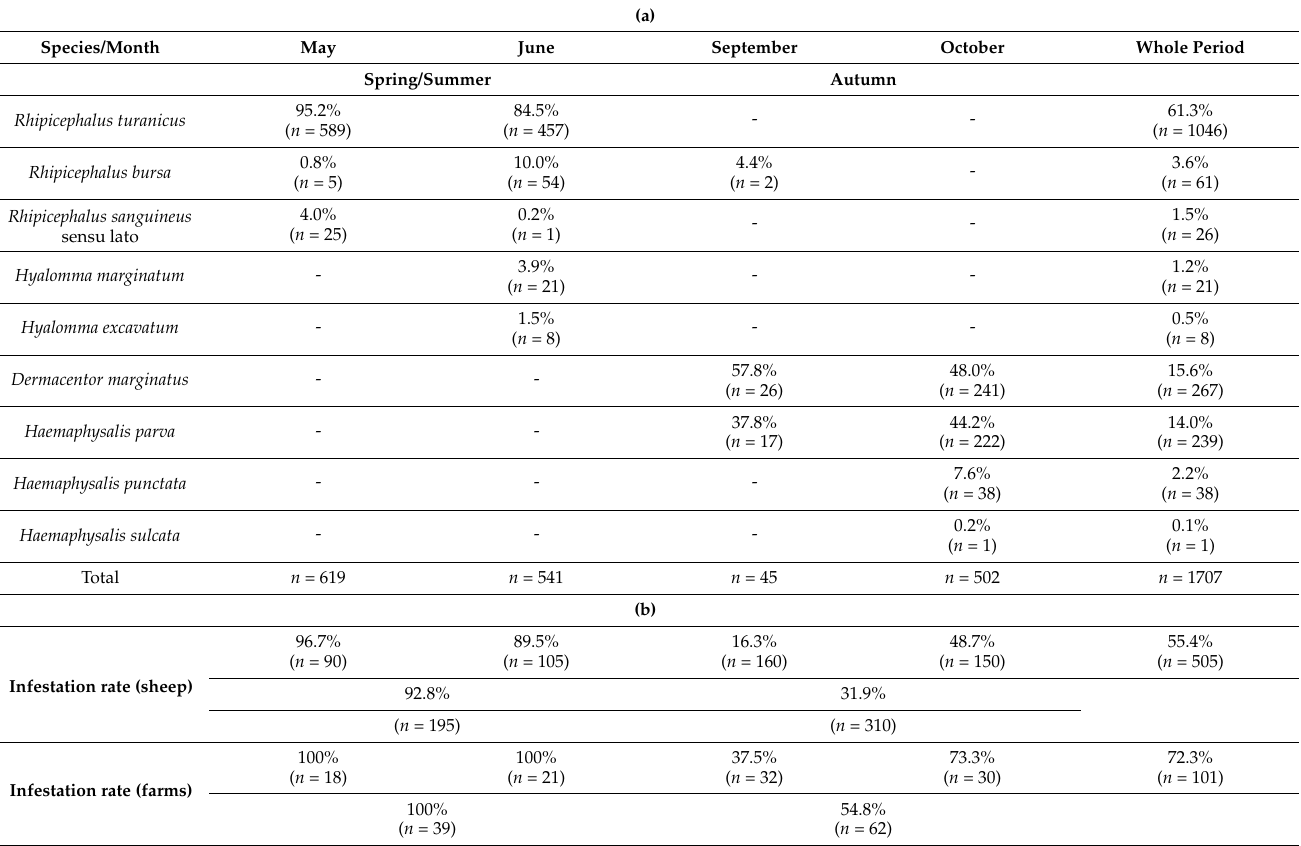
Table 1. ( a ) Distribution (rate, and total number in brackets) of tick species collected per month and total prevalence for the whole collection period are given. ( b ) Infestation rates at the animal or farm level stratified by month, collection period, or the whole study are additionally provided.